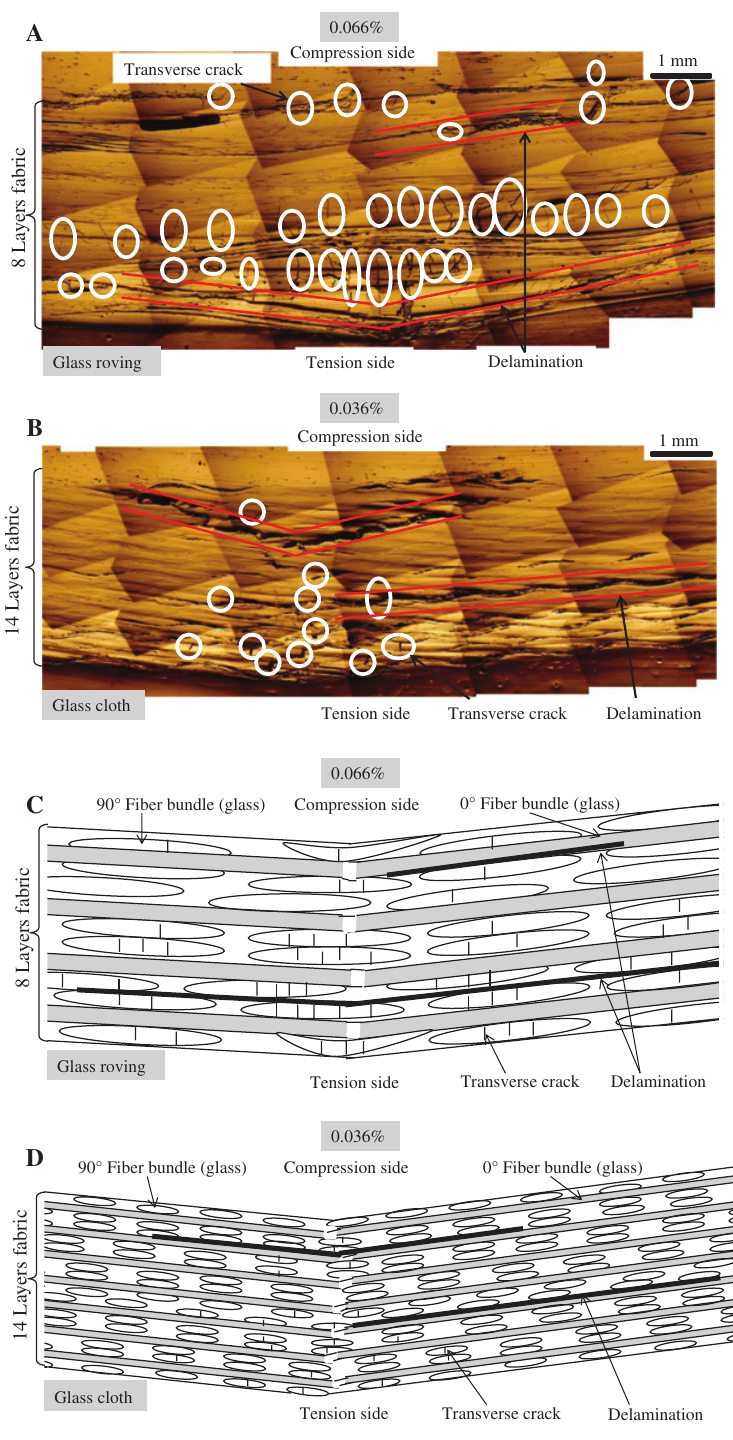
Figure 11 Cross-sectional photographs and schematic drawings of specimens with final fracture during the three-point bending test: (A and C) glass roving and (B and D) glass